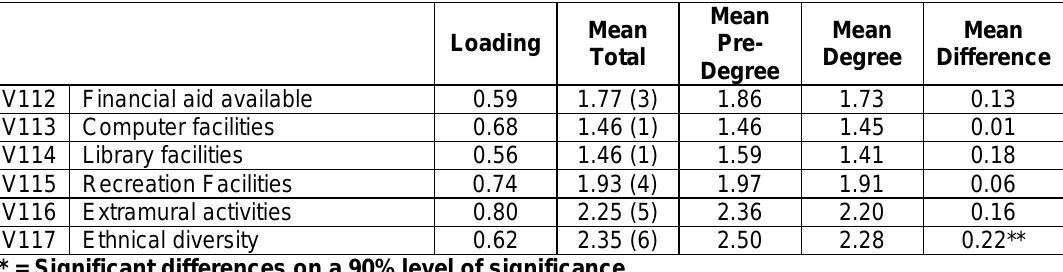
Table 2: Auxiliary